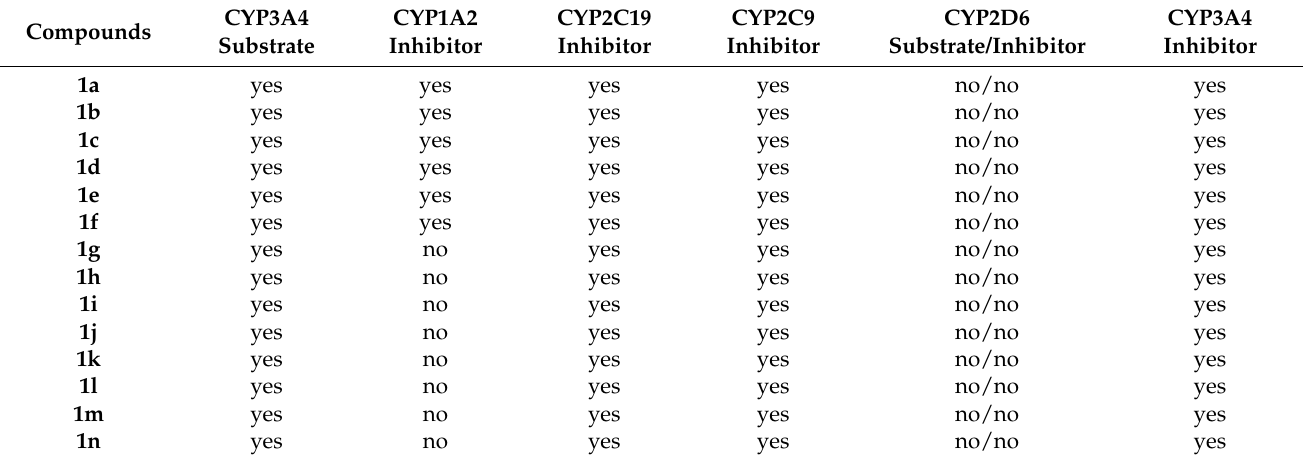
Table 7. The inhibitor/substrate features of natural compounds for CYP2D6, CYP3A4, CYP1A2, CYP2C19, and